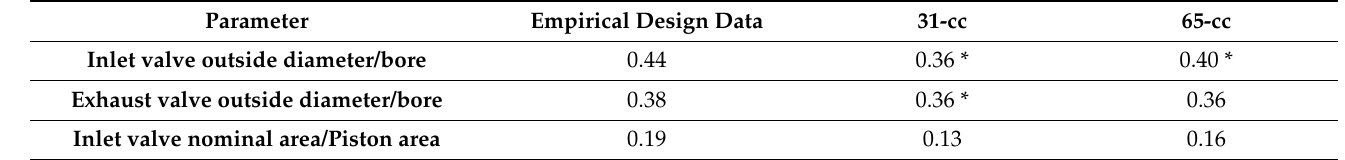
Table 2. Empirical design data for valve capacity and head design in relation to the actual design for the 31-cc and 65-cc Stihl 4MIX